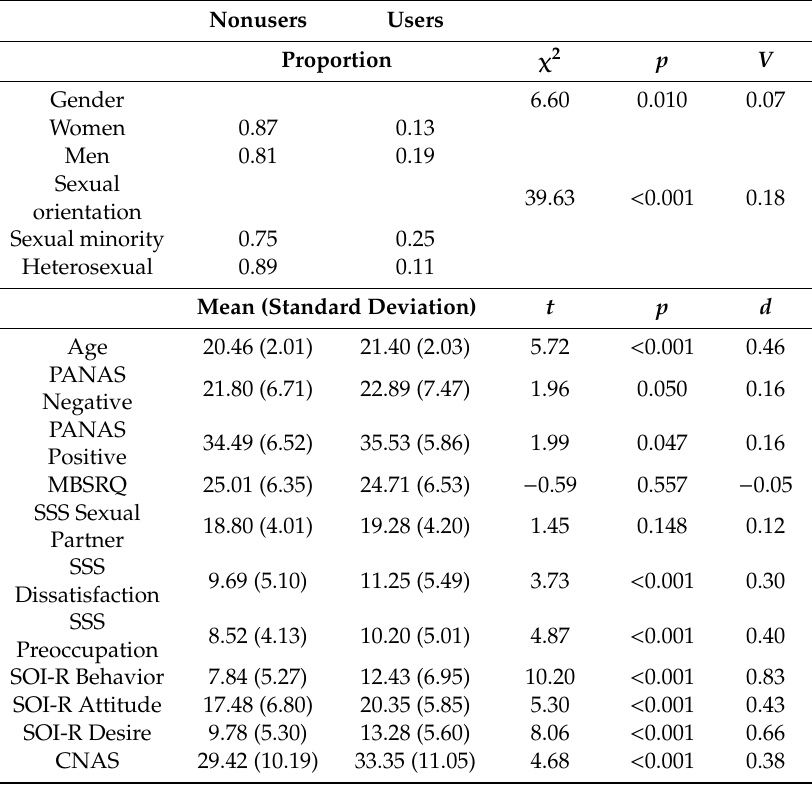
Table 1. Means and standard deviations for age, proportions for gender and sexual orientation, and significance testing according to Tinder